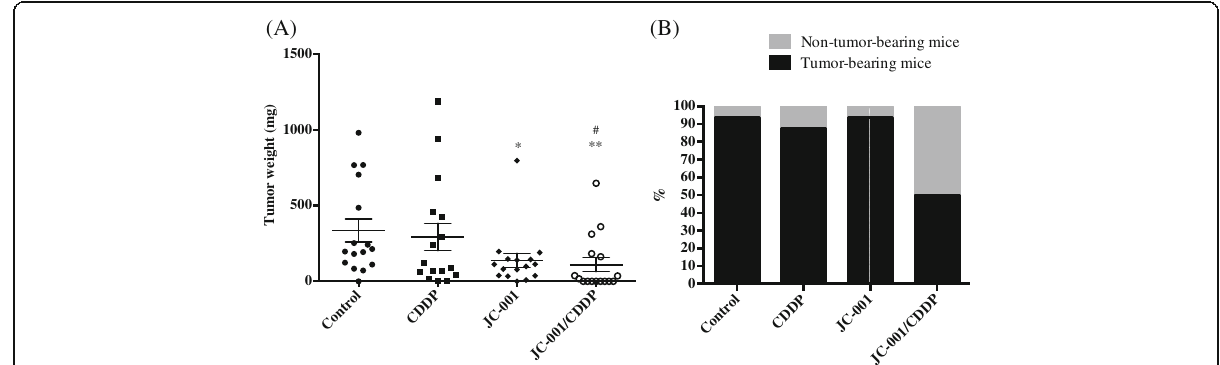
Fig. 4 JC-001 enhances the chemosensitivity of the LLC1 tumor model to CDDP. a Tumor mass. b Percentages of tumor/non-tumor-bearing mice in the groups ( n = 16). * p < 0.05, ** p < 0.01 compared with the control group, # p < 0.05 compared with the CDDP-treated group. After JC-001/CDDP combined therapy, the percentage of non-tumor-bearing mice was significantly enhanced from 6.25% to 50% compared with the control group, p = 0.0031